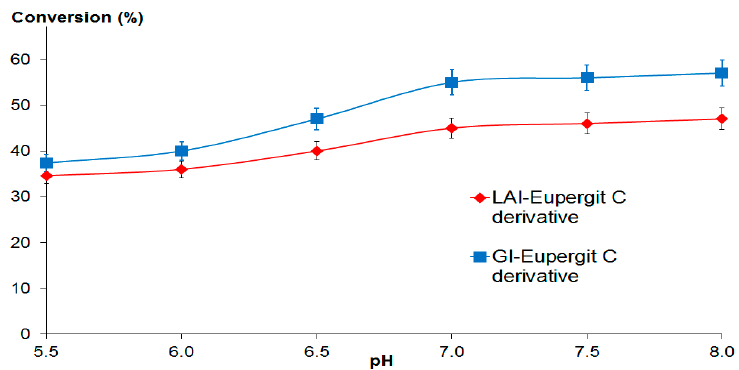
Figure 4. Influence of pH on the activity of stabilized L -arabinose ( D -galactose) isomerase (LAI) and D -xylose ( D -glucose) isomerase (GI) immobilized onto Eupergit C during batchwise operation at 60 °C with D -galactose and D -glucose (100 g/L), respectively.